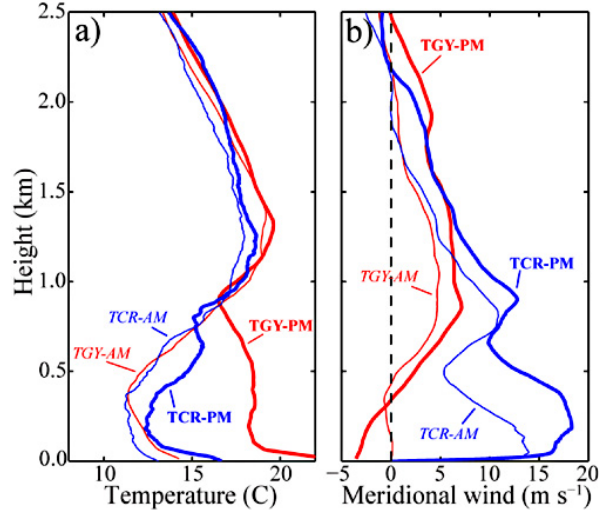
Fig. 13. Central map: colour-coded wind speed measured by the AIMMS-20 onboard of the BE90 during a portion of the research flight Met-6 (11 January 2011). Between 14:00–15:00LT the BE90 flew over the bay of Tongoy between 170 and 220ma.s.l. A few wind barbs are included to illustrate the general SW flow in this re- gion. The near coastal jet immediately to the north of point Lengua de Vaca (LdV) is evident (marked with a J in the hand made anal- ysis). The lower inset shows the wind speed, zonal and meridional components at about 200ma.s.l as a function of the longitude in a near zonal transect at 30.2 ◦ S. The dashed green line indicates the axis of the coastline south of LdV.